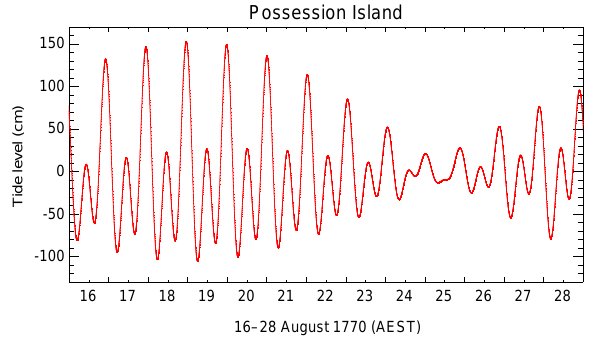
Figure 6. The tide at Possession Island at the end of August 1770. Mean time at the longitude of Possession Island (142 ◦ 42 (cid:48) E) is half an hour behind